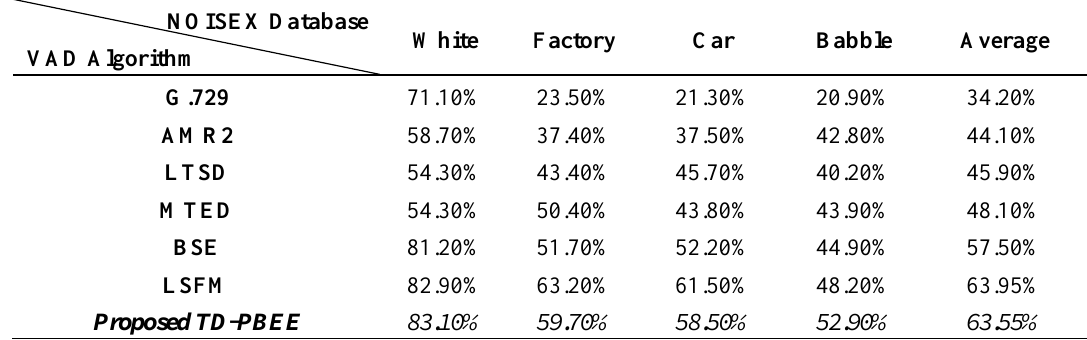
Table 2. Non-speech hit rate (HR0) from clean to 5 dB under the four types of noise.